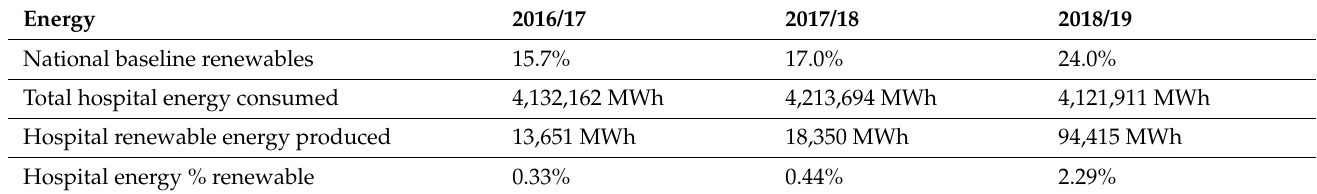
Table 4. Australian baseline renewable energy and public hospital energy use and renewable energy